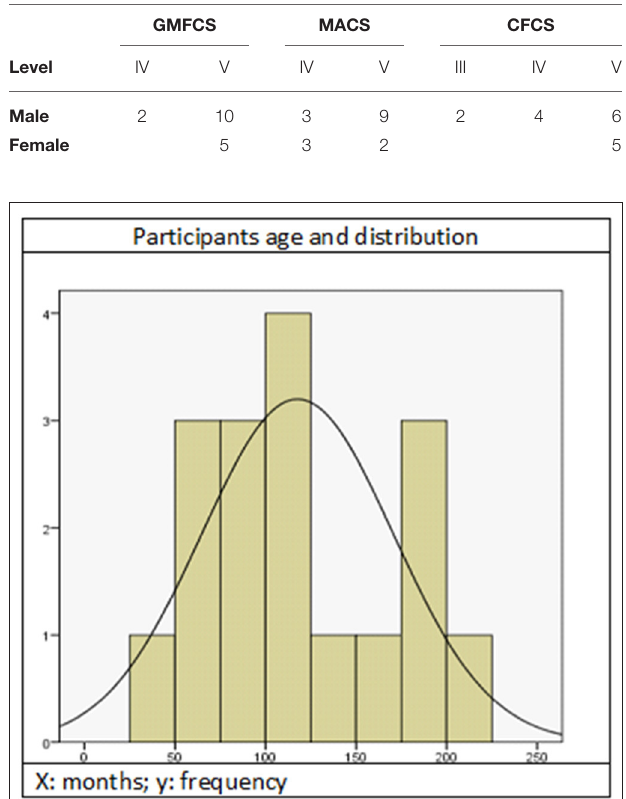
FIGURE 1 | Participants age and distribution. X, months; Y,